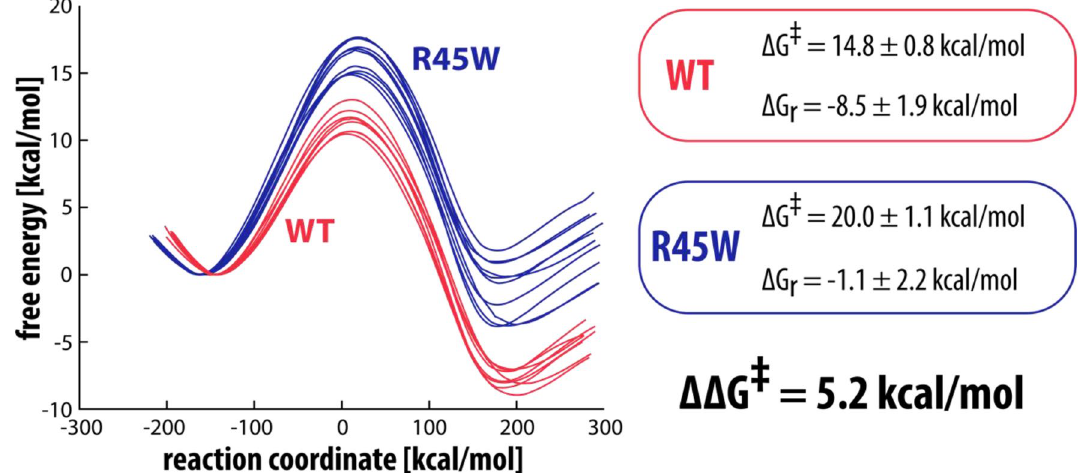
Figure 3. Free energy profiles for the rate-limiting step reaction between serotonin and the flavin cofactor in WT (red) and in R45W mutant (blue). The free energy barrier and the reaction free energy are also listed for both WT and R45W, with corresponding standard